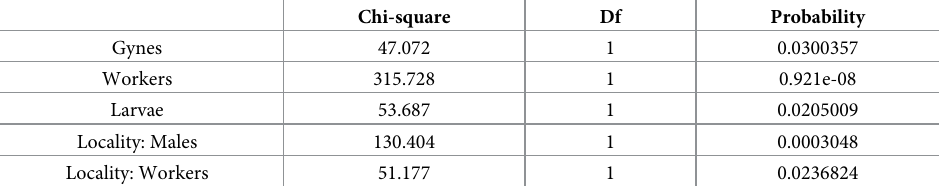
Table 2. Binomial GLM comparing queenright vs. queenless nests. Only significant results of the deviance analysis between population and structural variables of the 152 complete nests of E . ruidum sp. 2 extracted during the whole study are presented here. The number of workers and larvae was significantly higher in queenright nests while queen- less nests had a significantly higher number of gynes. Queenright nests at ‘Cauca’ tended to have fewer males and more workers than at